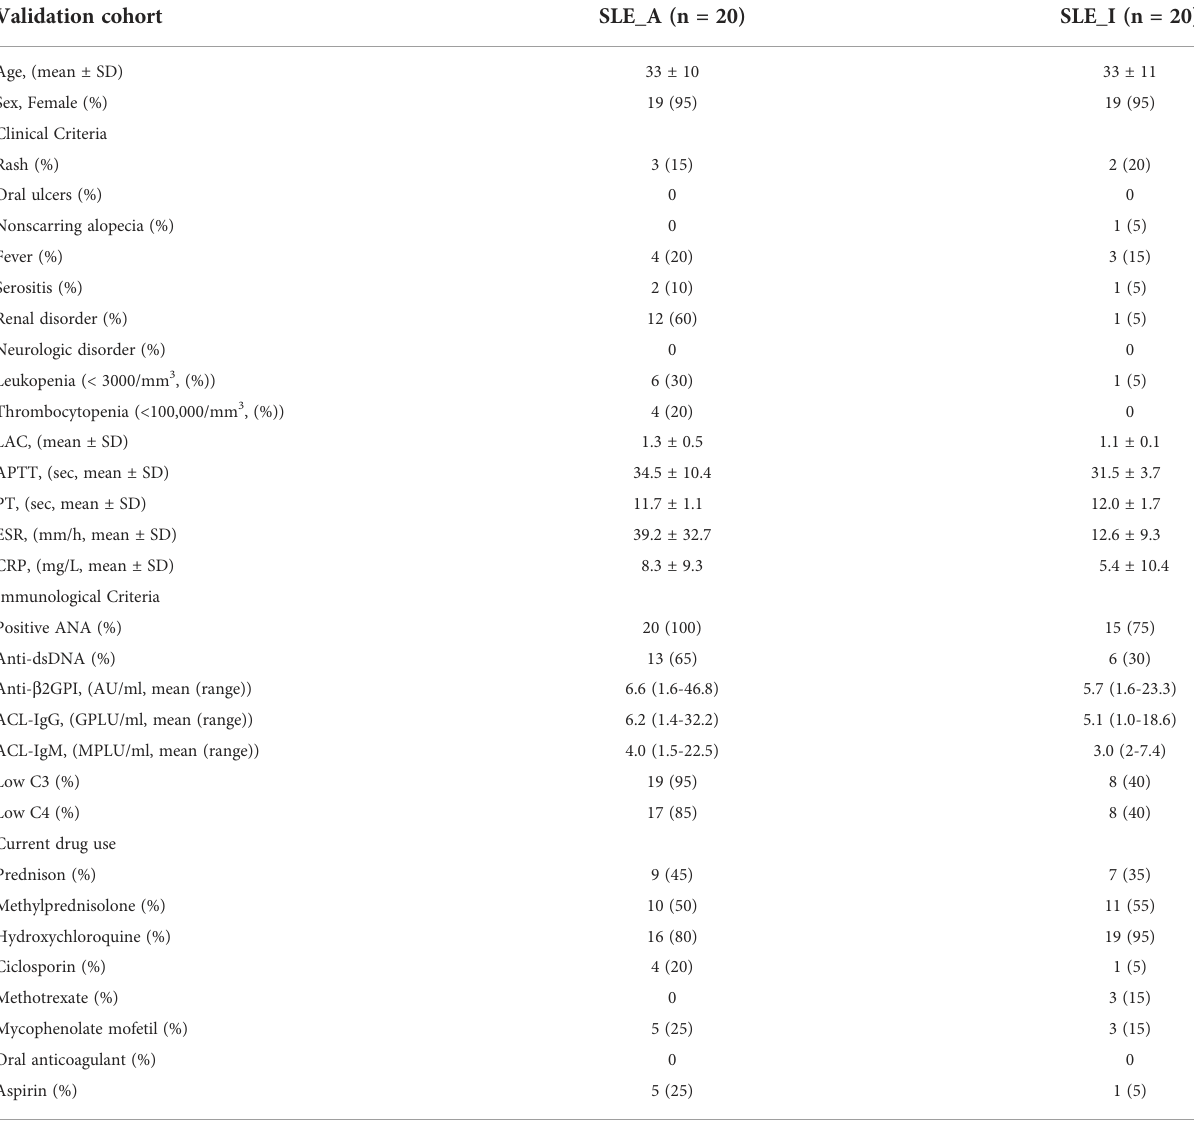
TABLE 3 Clinicopathologic characteristics of the SLE patients from validation